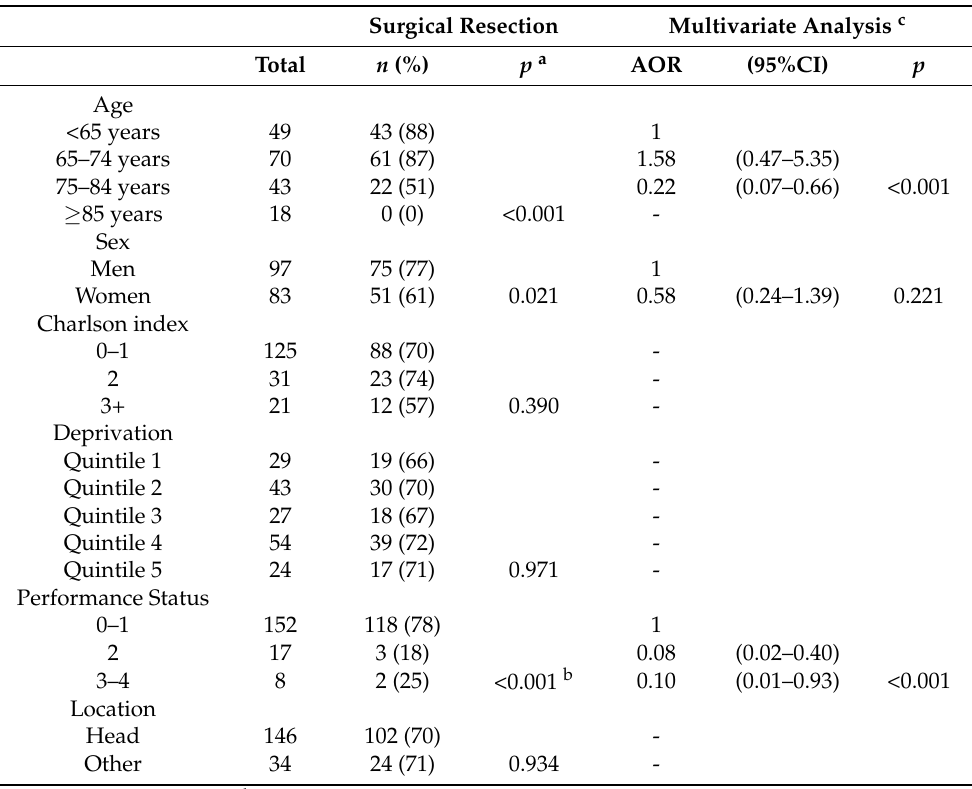
Table 2. Factors associated with the occurrence of surgical resection in patients with resectable M0 pancreatic cancer ( n = 180).